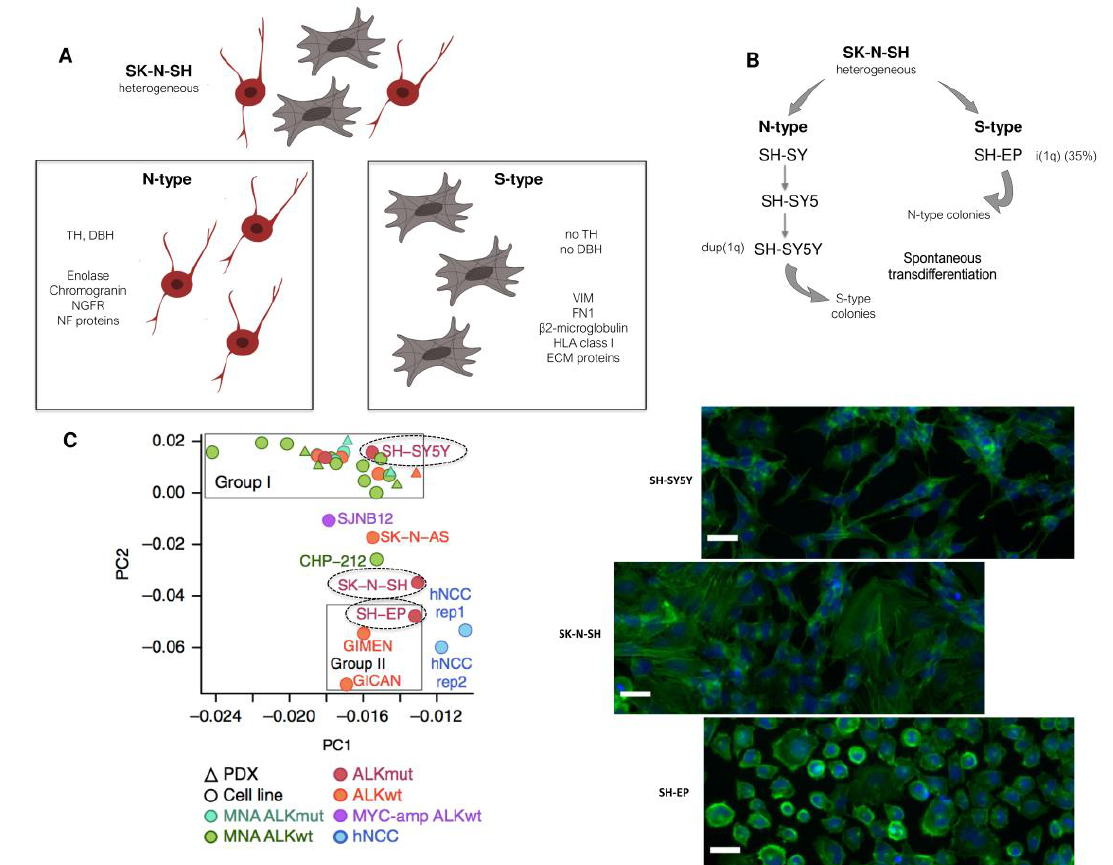
Figure 1. Heterogeneity of cell phenotype and identity in neuroblastoma cell lines. ( A ) The SK-N-SH cell line is het- erogeneous with two distinct populations. The N-type population is constituted by cells with neurites, expressing the noradrenergic enzymes tyrosine hydroxylase (TH) and dopamine- β -hydroxylase (DBH) and markers such as enolase, chromogranins, neurofilaments (NF) proteins, or the NGF receptor. The S-type population includes substrate-adherent cells expressing markers including vimentin (VIM), fibronectin (FN1), β 2-microglobulin, extracellular matrix (ECM) proteins, or HLA class 1 antigens. ( B ) Sub-lines derived from the heterogeneous SK-N-SH. The thrice-cloned SH-SY5Y sub-line presents an N-phenotype with a karyotype with a duplication of the chromosome 1q (dup(1q)), whereas the SH-EP sub-line presents an S-phenotype with an isochromosome 1q (i(1q)) in 35% of the cells. Interestingly, both cell types can undergo a spontaneous bidirectional interconversion. ( C ) Analysis of the SE landscape of the SK-N-SH, SH-SY5Y, and SH-EP cell lines revealed that epigenetic regulation shapes cellular identity (principal component analysis based on super-enhancer scores. Image is from “Heterogeneity of neuroblastoma cell identity defined by transcriptional circuitries” by Boeva, V. et al., 2017, Nature Genetics, 49, 1408–1413, Reprinted with permission from Ref. [19]. Copyright 2021 Springer Nature). The SH-SY5Y cell line is included in group I corresponding to a noradrenergic identity, while the SH-EP cell line is in group II, close to human NCC lines. The heterogeneous SK-N-SH cell line is included in an intermediate group. The different phenotypes of the cells of the corresponding cell lines are shown by immunofluorescence with Phalloïdin (green) and DAPI (blue). Scale bar = 20 µ